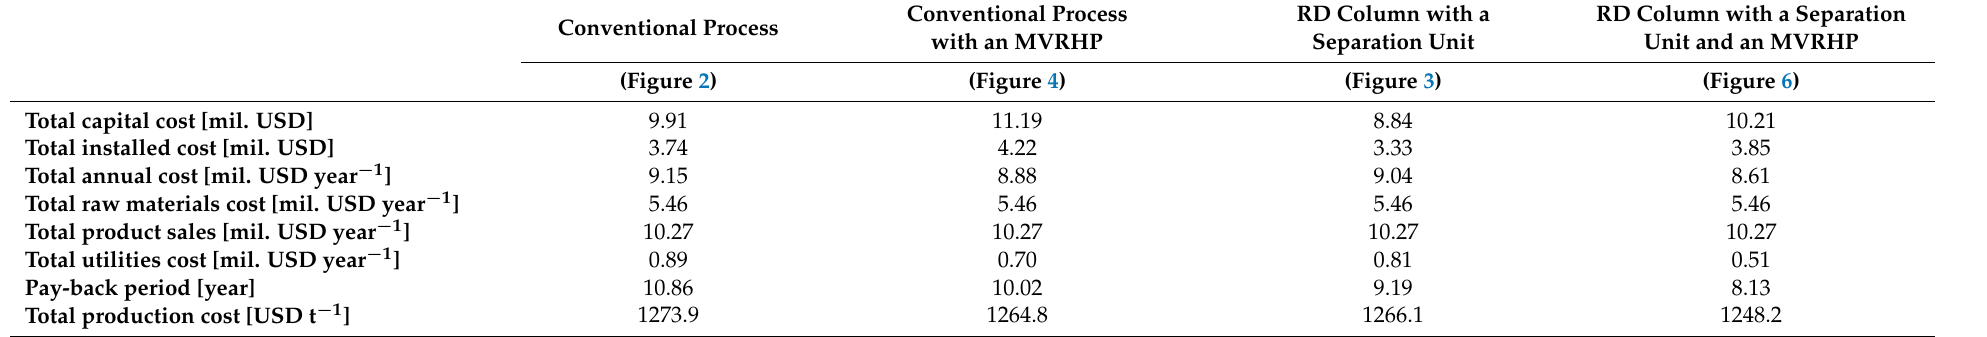
Table 7. MVRHP effect on total annual costs of designed